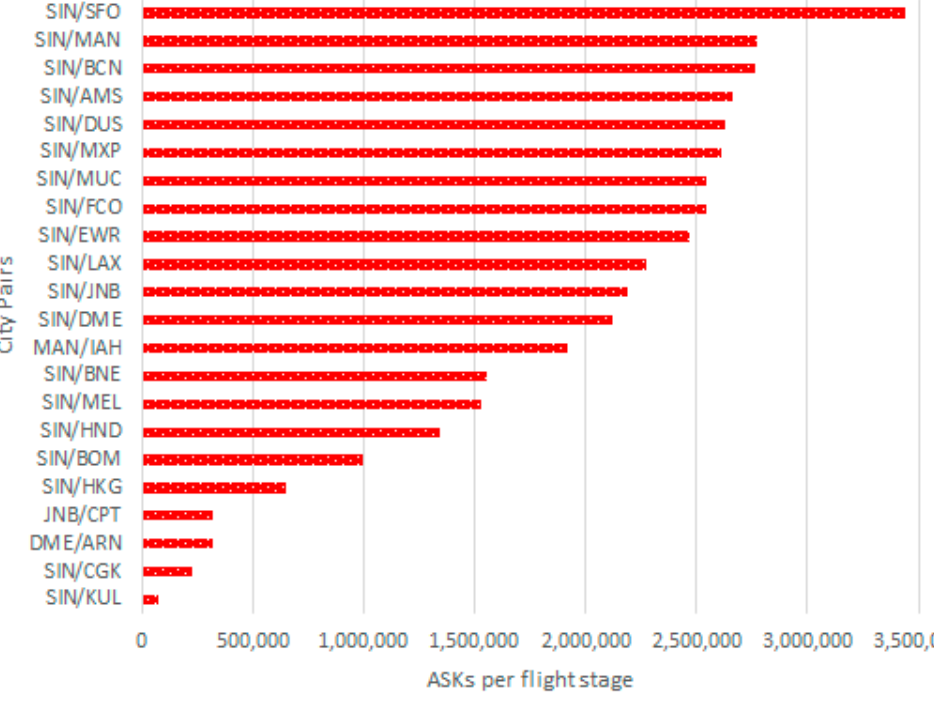
Figure 7. Singapore Airlines Airbus A350-900XWB ASKs per city pair. Legend: AMS = Amsterdam, ARN = Stockholm Arlanda Airport, BNE = Brisbane, BCN = Barcelona Airport, BOM = Chhatrapati Shivaji International Airport (Mumbai), CGK = Jakarta, CPT-Cape Town, DME = Domodedovo Airport (Moscow), DUS = Düsseldorf, FCO = Leonardo da Vinci–Fiumicino Airport (Rome), HKG-Hong Kong, HND = Haneda Airport (Tokyo), IAH = George Bush Intercontinental Airport (Houston), JNB = Johannesburg Airport, KUL = Kuala Lumpur, MAN = Manchester Airport, MEL = Melbourne, MXP = Milan–Malpensa Airport, MUC = Munich Airport, SFO = San Francisco, SIN =